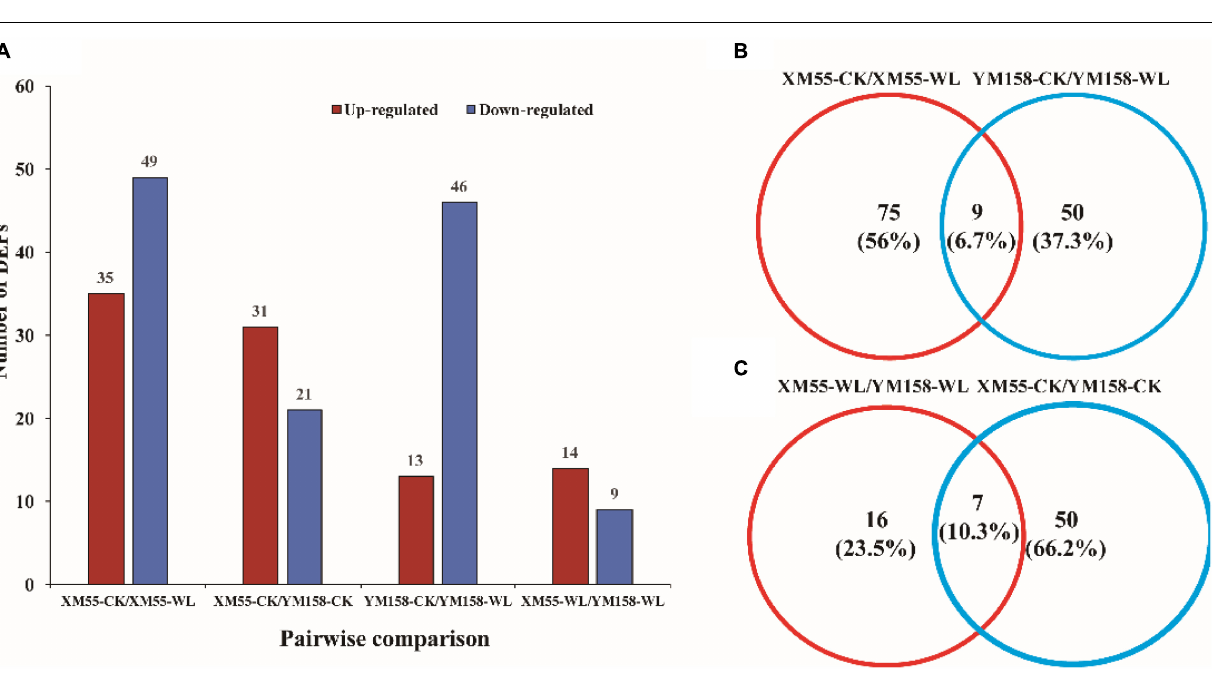
FIGURE 3 | Quantitative and Venn analysis of the proteome of two wheat cultivars under different treatments. (A) Quantitative analysis of the proteome between the waterlogging treated and control samples. (B) Venn analysis of two wheat cultivars under different treatments. (C) Venn analysis of different treatments in different wheat cultivars; XM 55 and YM 158 are the two cultivars; CK, control; WL,